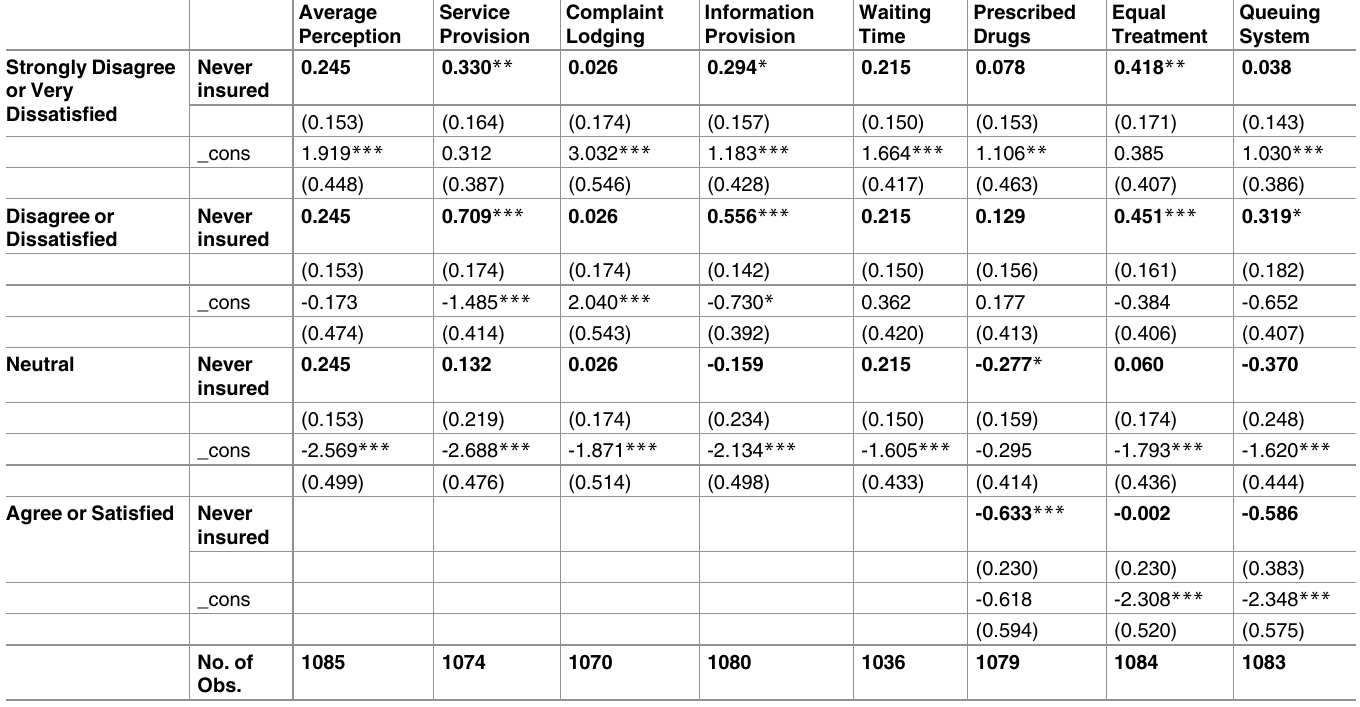
Table 4. Association of never insured status on perceivedquality of